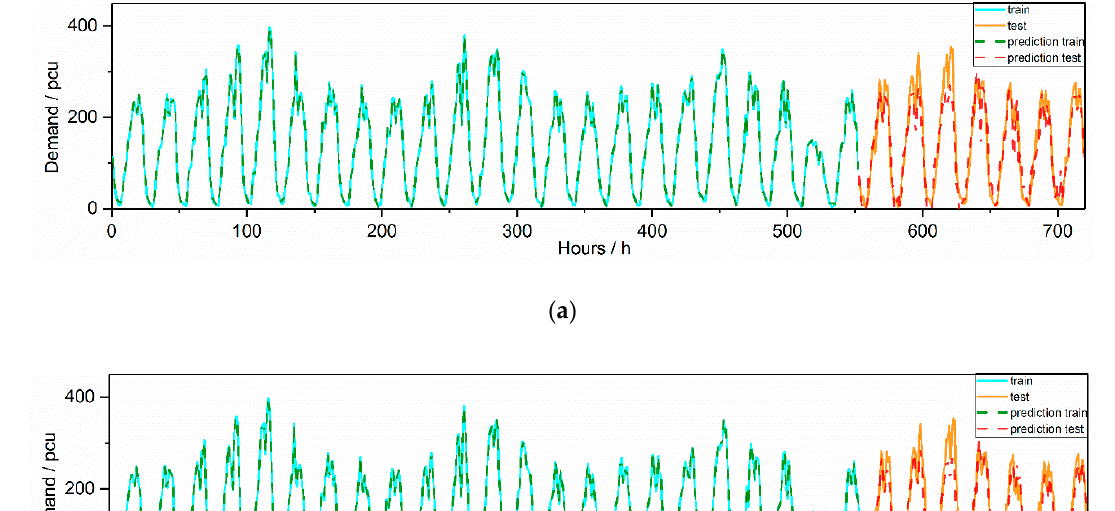
Figure 5. Online taxi-hailing demand prediction results of models based on BPNN. ( a ) Result of model